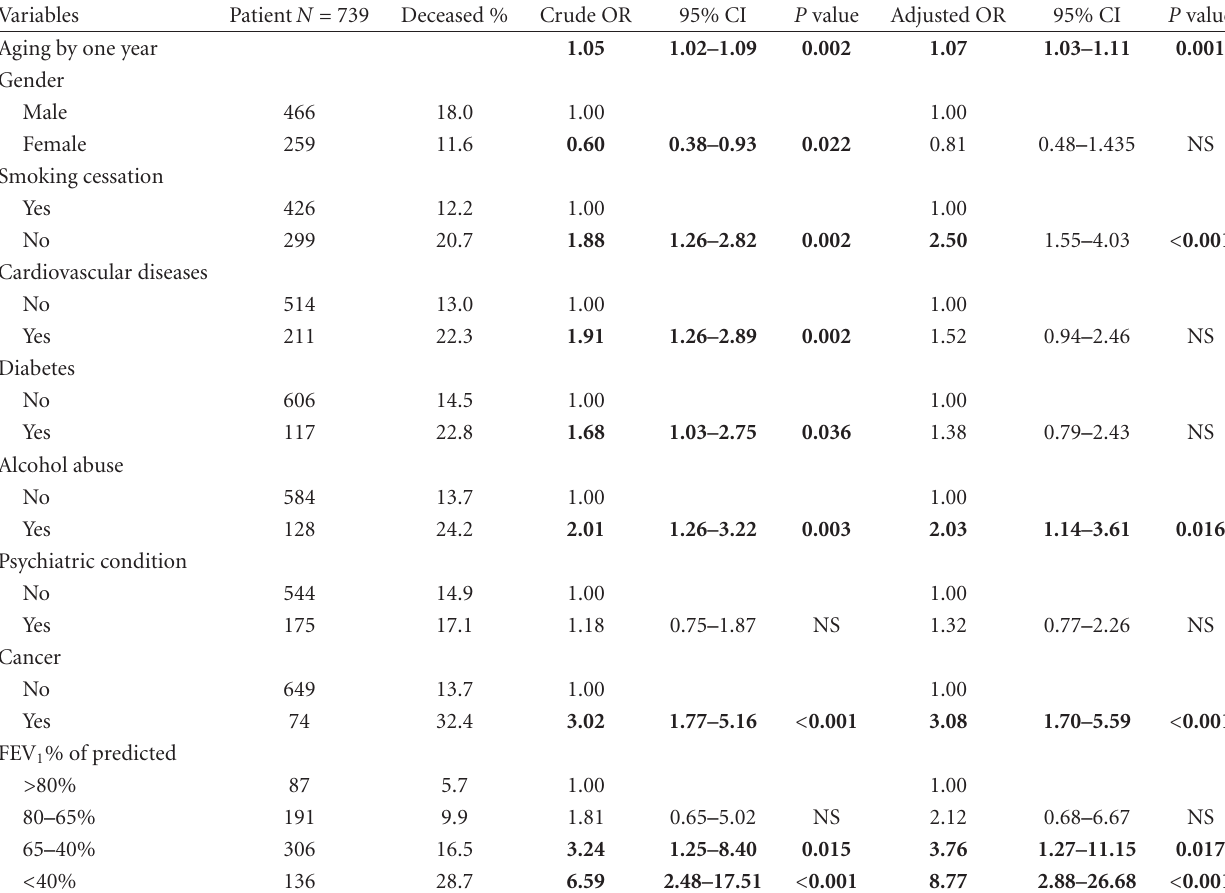
Table 3: Underlining clinical characteristics that predict mortality of the COPD patients during the four-year followup.